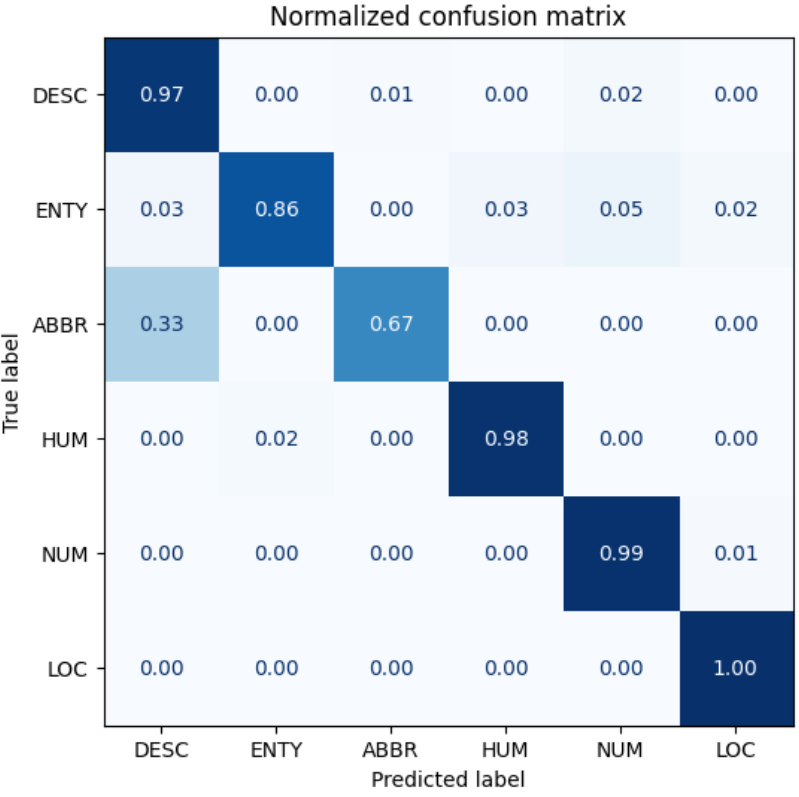
Figure 16. Antonym2 Run1 Confusion Matrix on TREC.